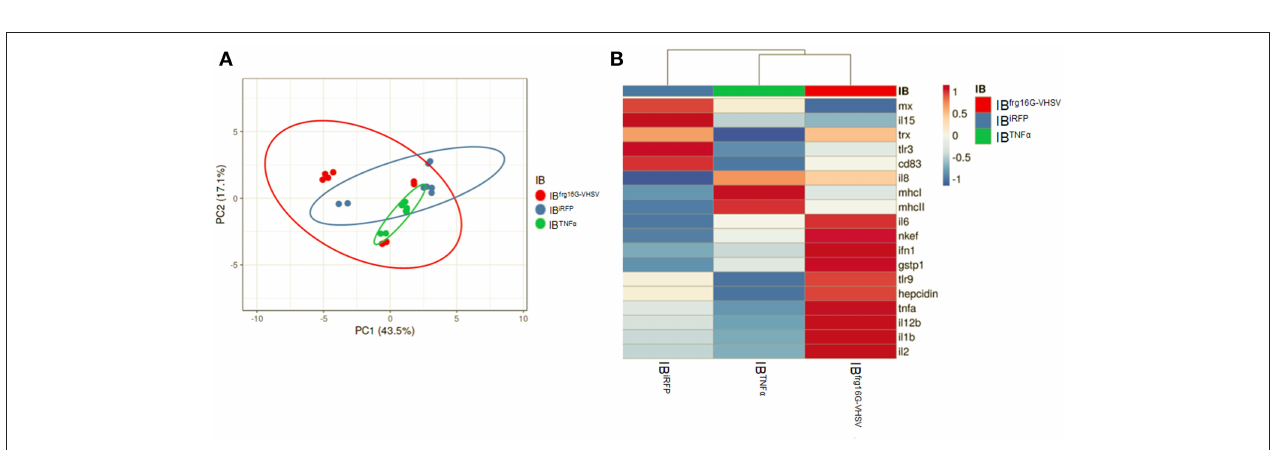
FIGURE 4 | Immune-gene expression analysis of RBCs from rainbow trout injected intravenously with PBS, IB iRFP , IB TNF α , or IB frg16G − VHSV at 24 and 48h post-injection. Rainbow trout of 15–20g were injected with 5.5 mg/kg of IB intravenously. Blood was extracted and RBCs Ficoll-purified 24h (A) and 48h (B) post-injection. Gene expression was analyzed by RT-qPCR, 2 − 1 Ct method, with endogenous gene eukaryotic 18S rRNA. Data represent mean AU (arbitrary units) ± SD ( n = 4). Mann-Whitney test was performed between each condition and control (treated with PBS or IB iRFP ). # P -value < 0.05, compared to PBS; & P -value < 0.05, compared to IB iRFP .